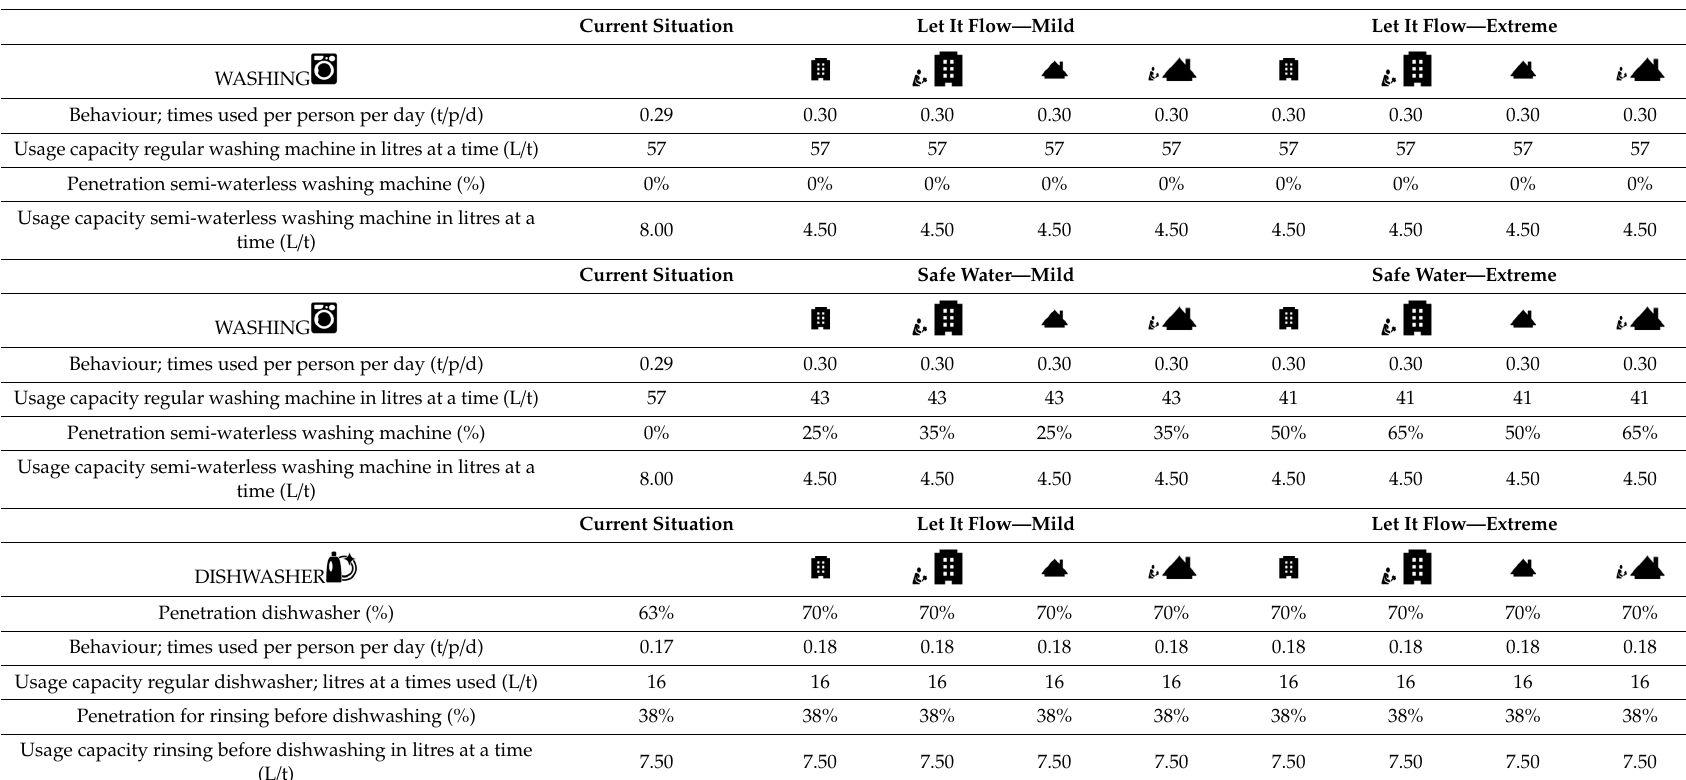
Table A3. Quantitative input data for individual water demands (STEP 6).